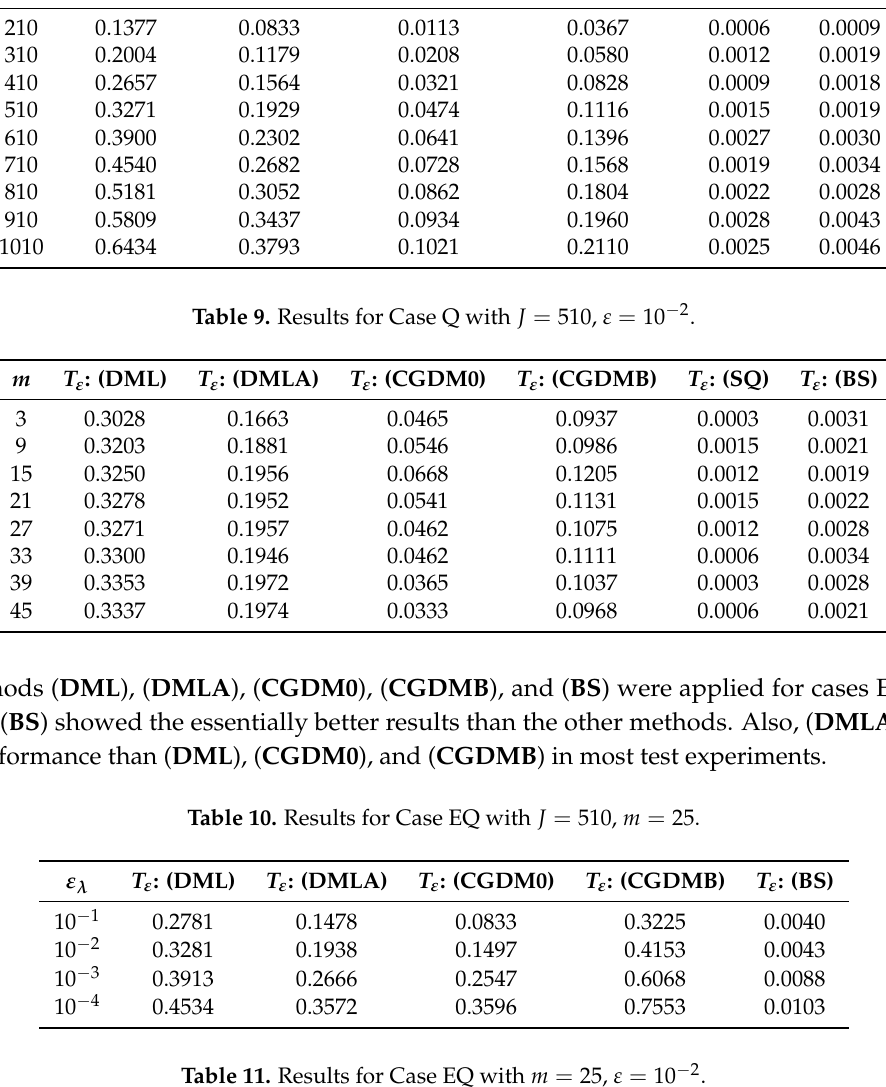
Table 11. Results for Case EQ with m = 25, ε = 10 − 2